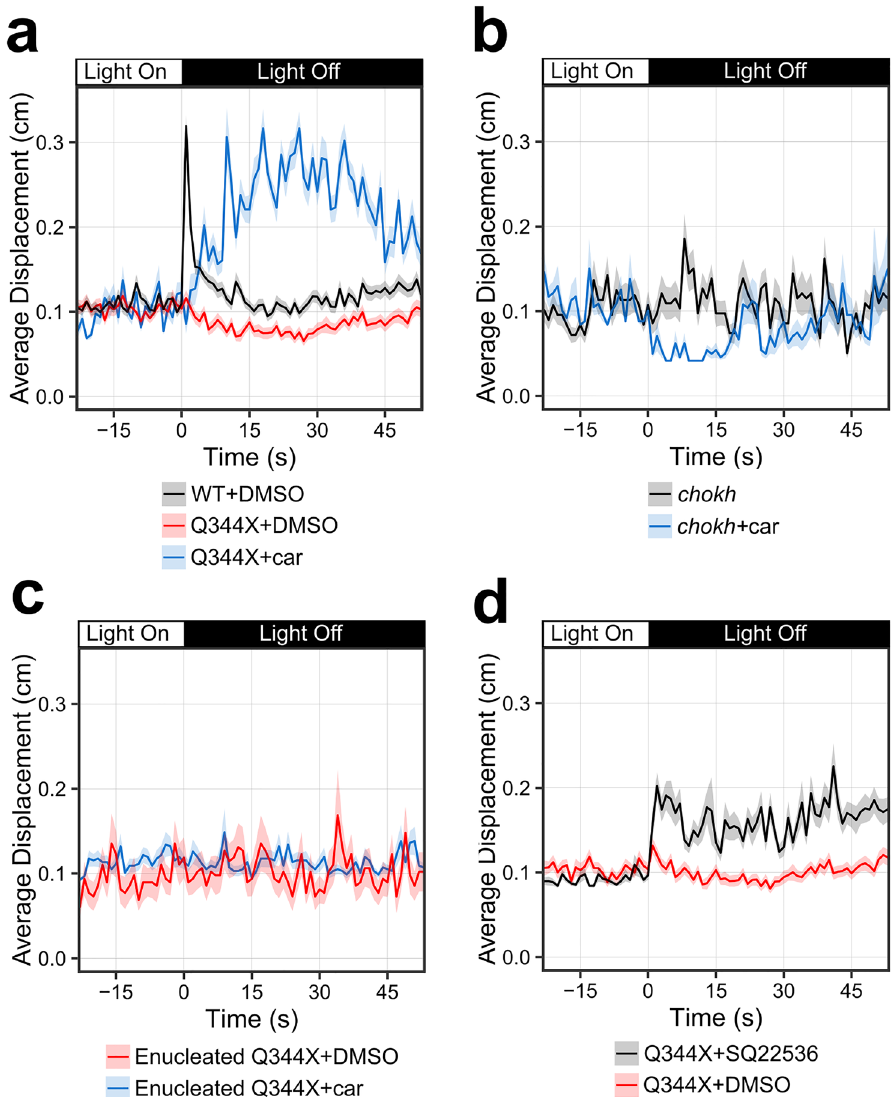
Figure 2. Drug screening on the Q344X zebrafish identified carvedilol as a beneficial drug. ( a ) Carvedilol treatment on Q344X larvae resulted in a sustained scotopic light-off VMR (blue trace, N = 2 replicates of 24 larvae) compared to that of both DMSO-treated WT larvae and DMSO-treated Q344X larvae (black and red trace respectively, N = 9 replicates of 48 larvae in each group). Each trace shows the average displacement of each replicate, and the color ribbons indicate µ ± s.e.m. The two carvedilol replicates were highly consistent and not different from each other (High-Dimensional Nonparametric Multivariate Test, N = 24, T HD = 1.78, p value = 0.91). Each replicate demonstrated a significant change in behavior for the duration of 30 s after light offset above DMSO-treated Q344X larvae (Hotelling’s T-squared test, N = 24, T = 378.0 and 456.0, df = 30, p value < 0.0001 for each replicate). ( b ) To determine if carvedilol’s effects are elicited through the retina, eyeless chokh fish were treated with carvedilol (blue trace) and their VMR was compared with untreated control (black trace). Carvedilol treatment did not increase the chokh VMR (Hotelling’s T-squared test, N = 24 larvae, T = 37.8, df = 30, p value = 0.946). ( c ) Q344X larvae were enucleated to determine if extraocular expression of Q344X RHO was causing the VMR seen with carvedilol treatment. Larvae were treated with carvedilol (blue trace) or DMSO (red trace) at 5 dpf and enucleated on the morning of 6 dpf. VMR was assessed at 7 dpf. Carvedilol showed no effect on enucleated Q344X larvae. (Hotelling’s T-squared test, N = 24 larvae, T = 28.8, df = 30, p value = 0.948). ( d ) Q344X larvae were treated with 100 μM adenylyl cyclase (ADCY) inhibitor SQ 22,536 (black trace) at 3 dpf to determine if inhibiting ADCY would improve the VMR compared to DMSO treatment (red trace). Treatment with SQ 22,563 significantly improve the Q344X VMR over DMSO treatment (Hotelling’s T-squared test, N = 3 replicates 24 larvae, T = 118, df = 30, p value <